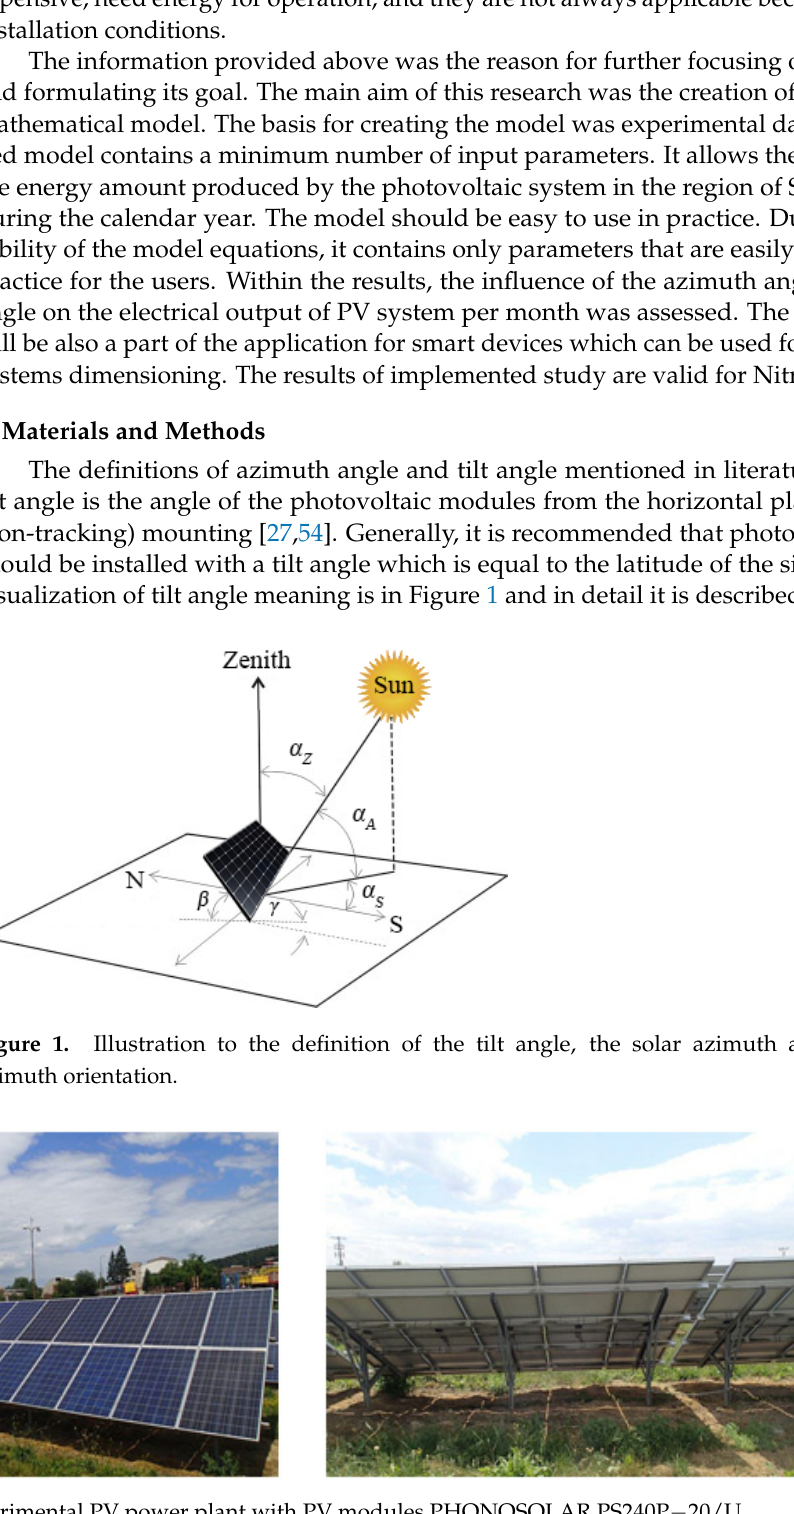
Figure 2. Experimental PV power plant with PV modules PHONOSOLAR PS240P −